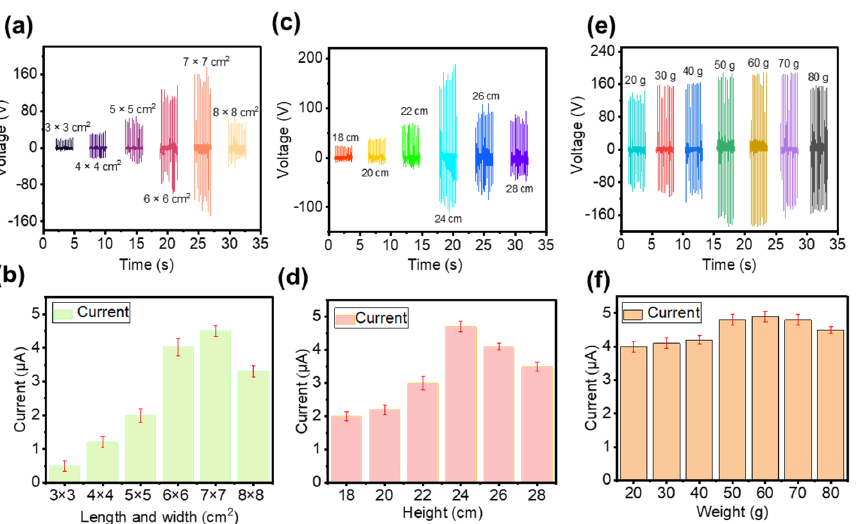
Figure 2. ( a , b ) V OC and I SC of the CS-TENG with different inner box lengths and widths. ( c , d ) V OC and I SC of the CS-TENG with different inner box heights. ( e , f ) V OC and I SC of the CS-TENG with different inner box weights.